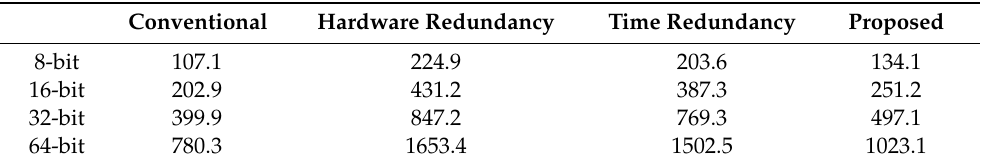
Table 1. Equivalent gate counts for various LFSR designs.